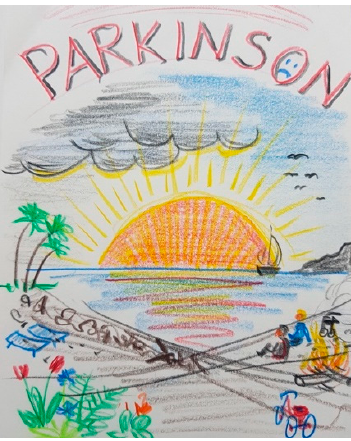
Figure 10. FC26’s perception of PD as a joint journey for the